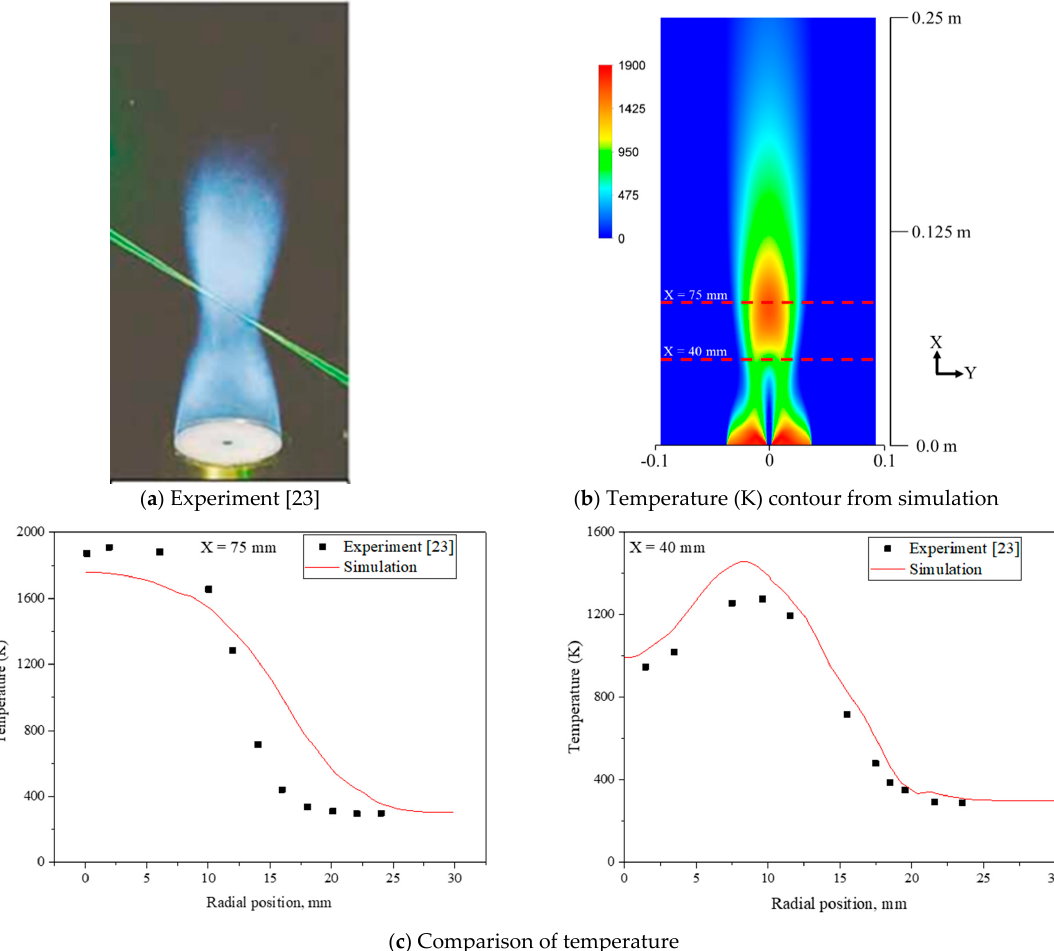
Figure 4. Comparison of the flame image from the experiment ( a ) with the temperature contour from the simulation ( b ); numerical comparison between the experiment and the simulation ( c ).